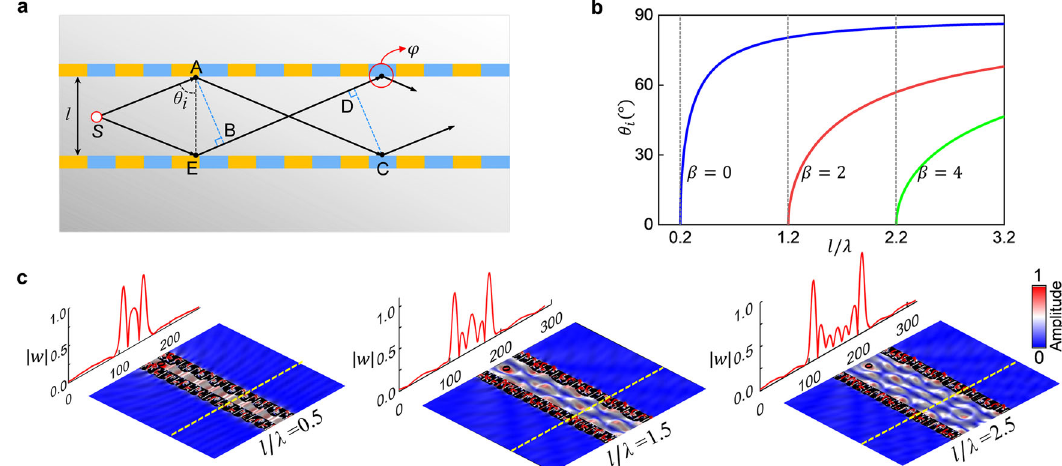
Fig. 5 Guided-mode theory for waveguides. a Schematic of omnidirectional wave re fl ection in a waveguide excited by a point source S placed in the middle of the waveguide. Points A and E are located symmetrically at the boundary of waveguide. Wave fi elds in points A and point C have the same phase with their projections B and D , respectively. φ represents the phase shift when total re fl ection appears at the waveguide boundary. b The guided-mode order β as functions of the ratio l/ λ and the incident angle θ i . The whole region is divided into three parts (0.2 – 1.2, 1.2 – 2.2, and 2.2 – 3.2), which represent different patterns in standing wave fi elds. c Simulated displacement fi elds | w | in the waveguides with l / λ = 0.5,1.5,2.5, respectively. The amplitude | w | on a typical line (dashed yellow line) crossing the waveguide (the orange curve) is examined in each